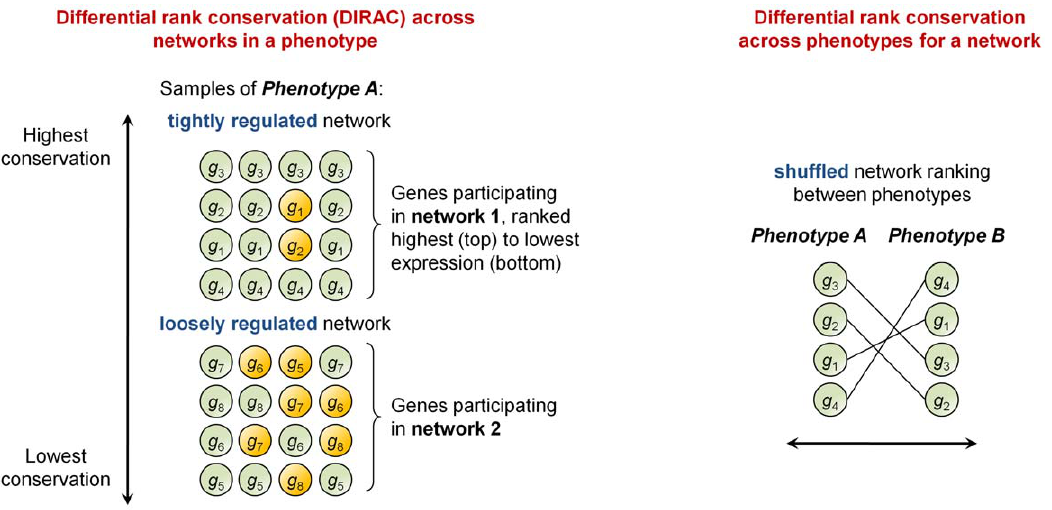
Figure 2. Prototypical scenarios observed for networks in DIRAC.